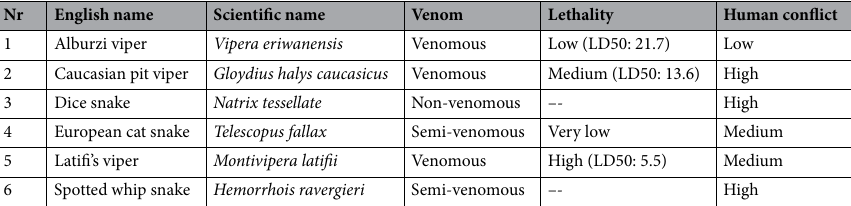
Table 6. Diversity of snakes of Lar National Park (following 1 ).